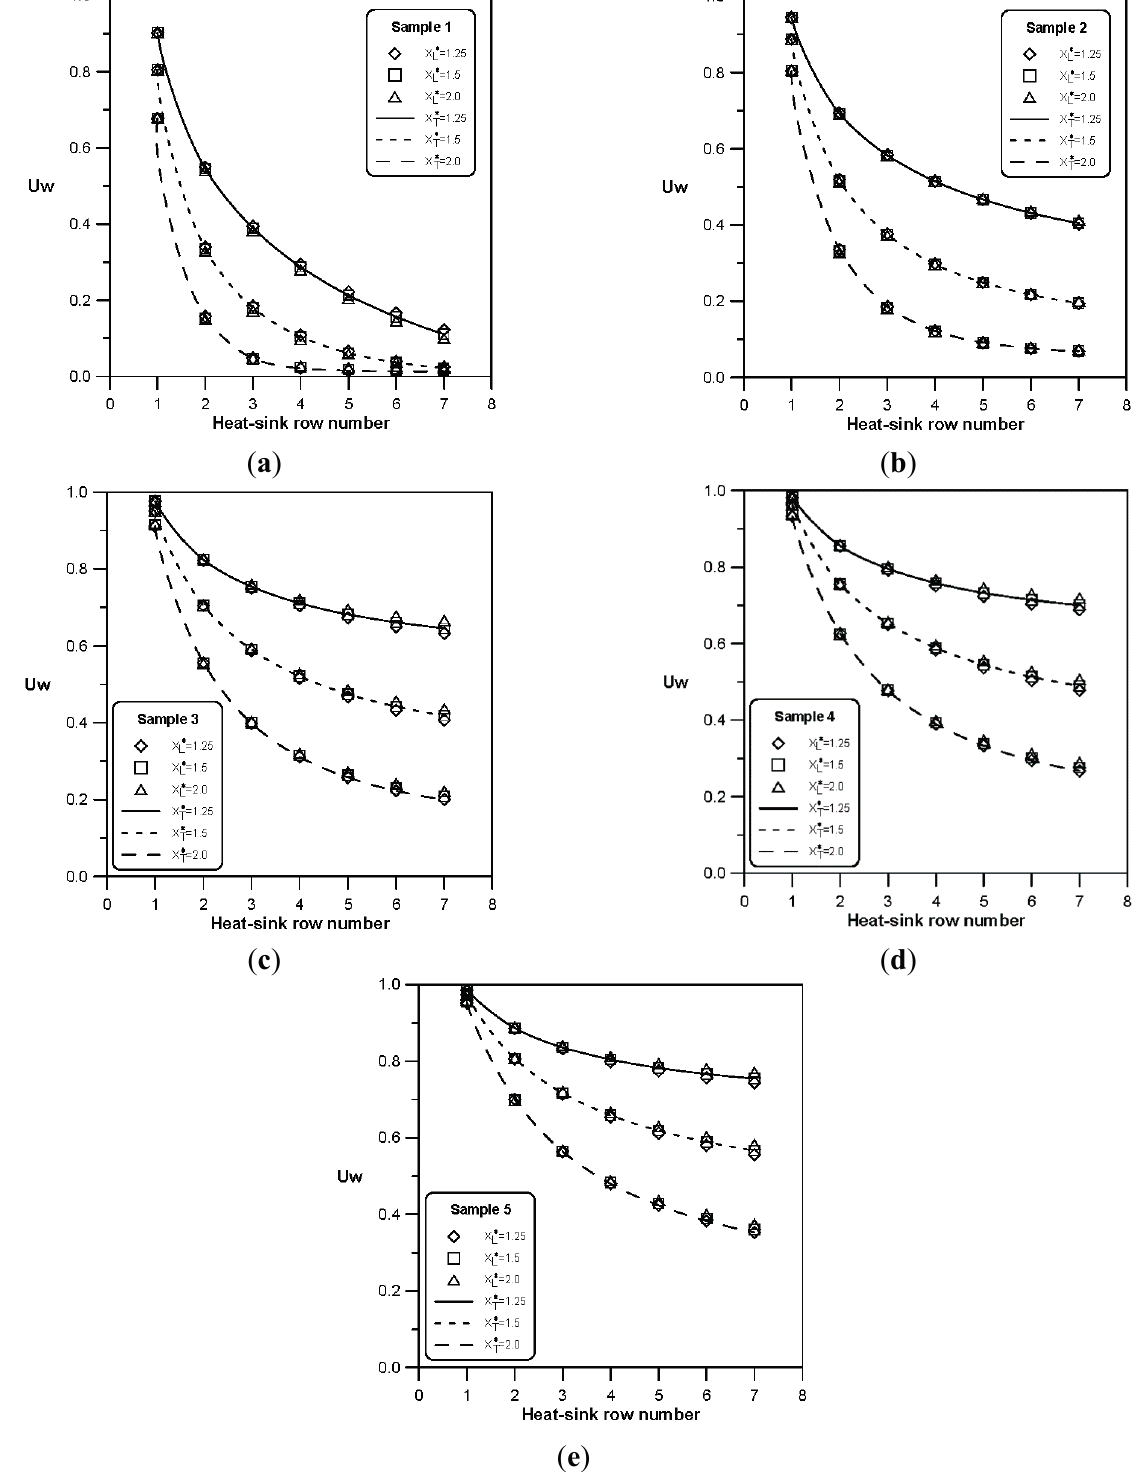
Figure 10. Dimensionless velocities of fluid flow through windward sides of various heat sinks: ( a ) Sample 1; ( b ) Sample 2; ( c ) Sample 3; ( d ) Sample 4; and ( e ) Sample 5. Figure 11 shows the dimensionless pressure drop when the air flow at Re = 500 passes through different heat sink arrays with different X T * and X L * values. The result indicates that changing X L * did not affect the dimensionless pressure drop, but increasing X T * would reduce dimensionless